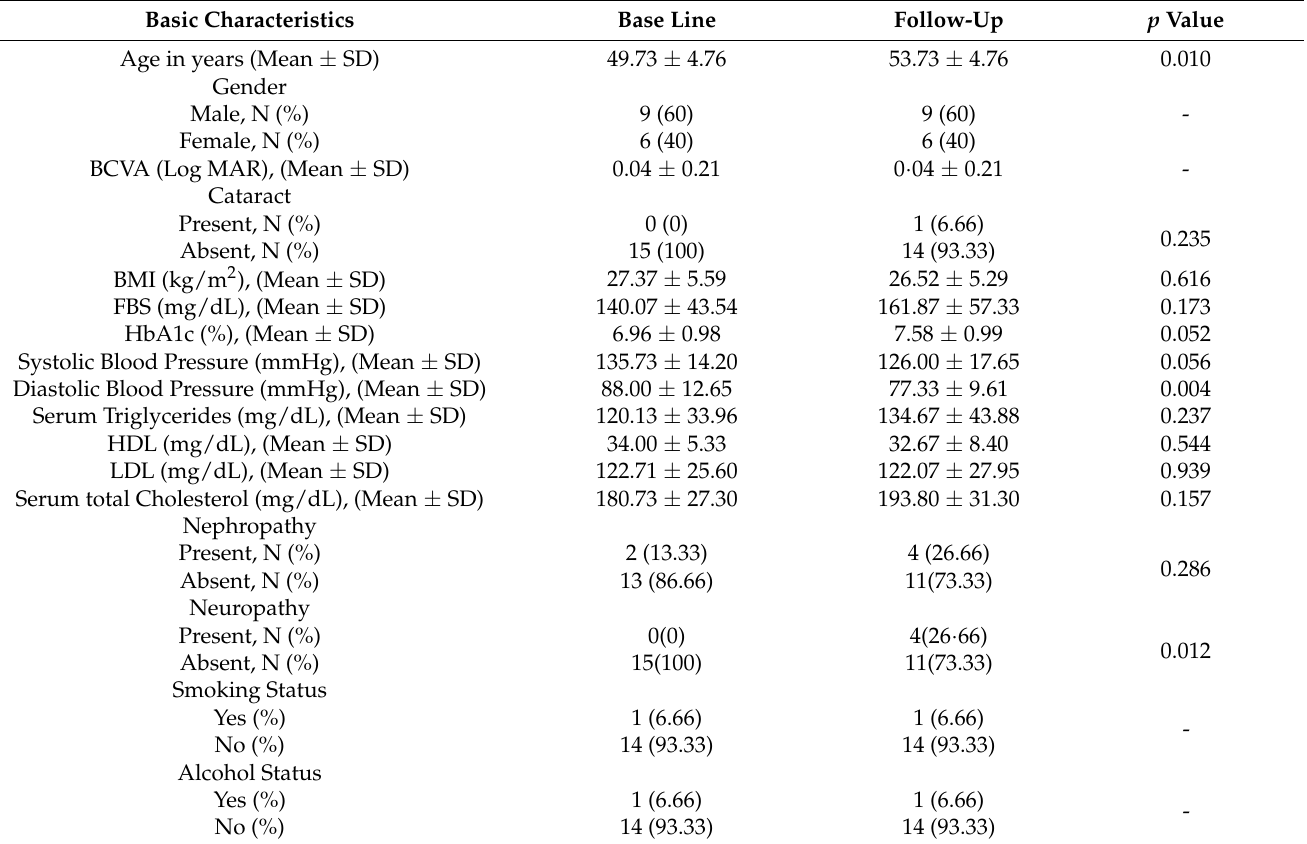
Table 2. The basic characteristics of the subjects at baseline and at